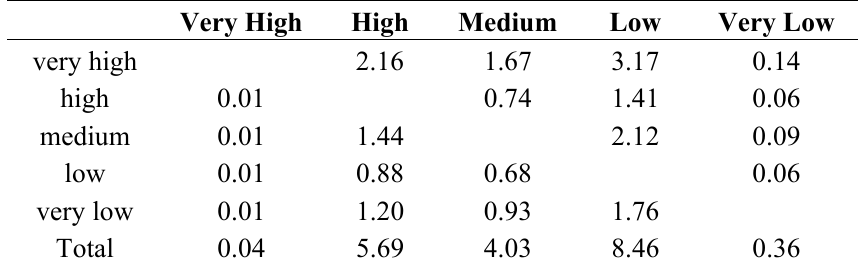
Table 8. Expected number of misclassified observations based on random error